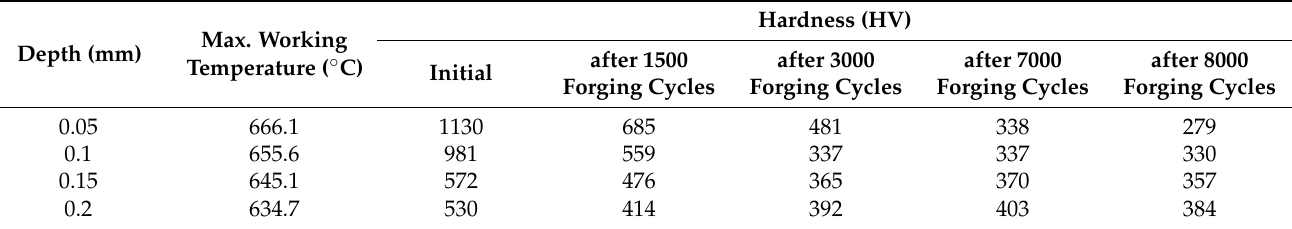
Table 2. Hardness of dies at indicated analyzed